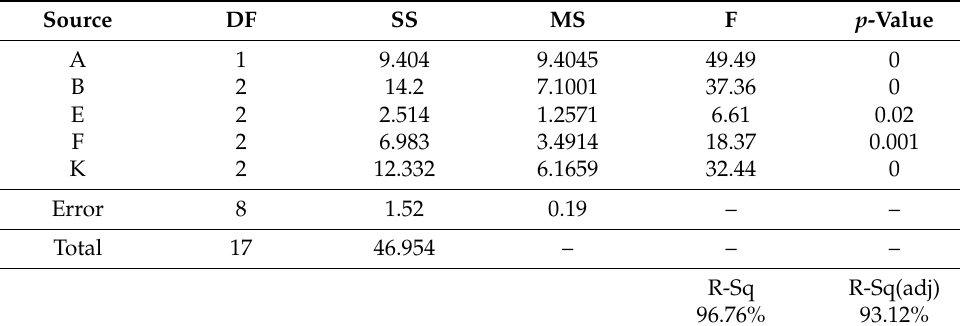
Table 11. ANOVA on the S/N ratios of the L 18 (2 1 × 3 7 ) experiment.